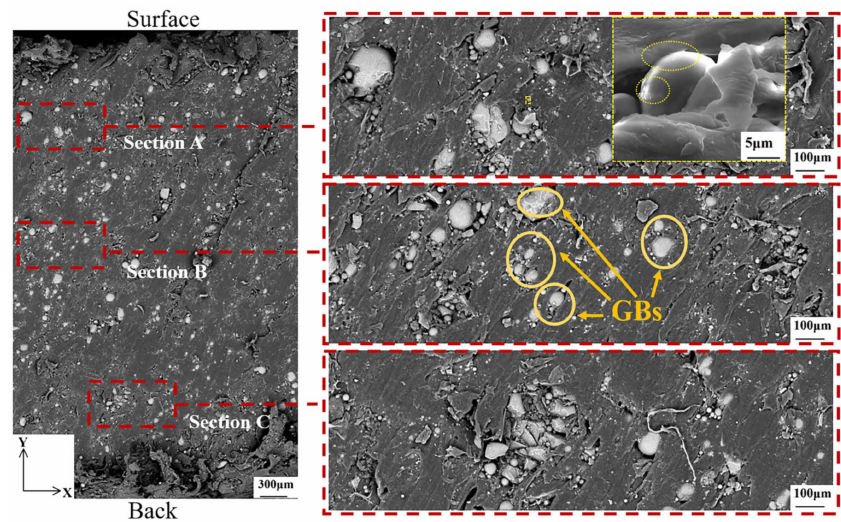
Figure 8. Microscopic morphology of the motor before ablation in the XOY direction. The larger yellow dashed rectangle is an enlarged view of the smaller yellow dashed rectangle.